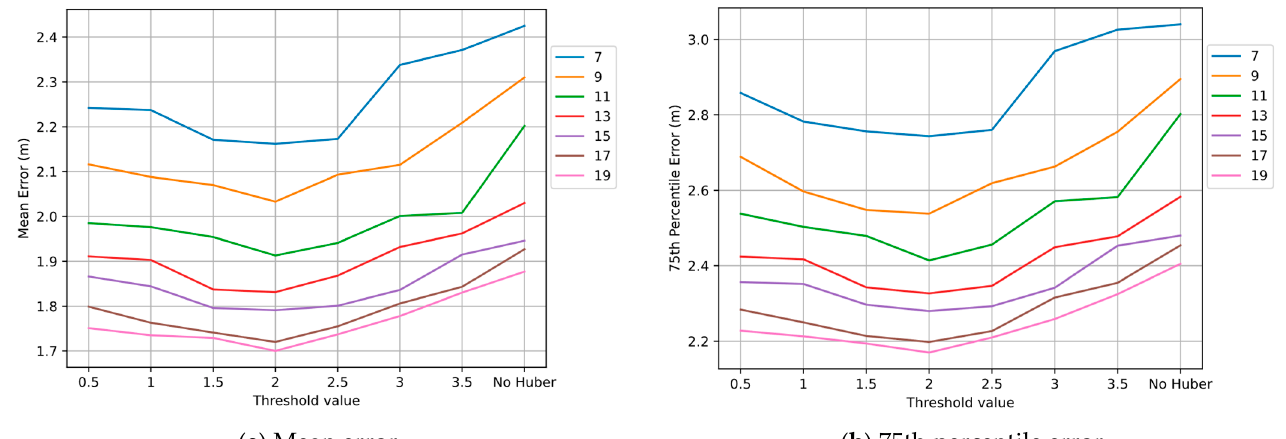
Figure 8. Positioning errors under different thresholds 𝛿 .